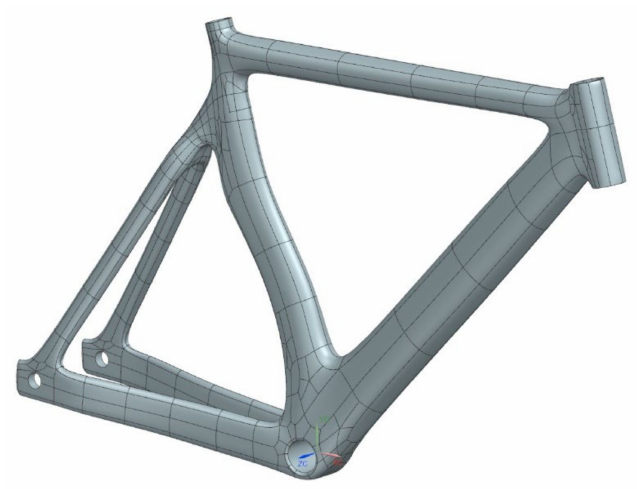
Figure 15. Final frame